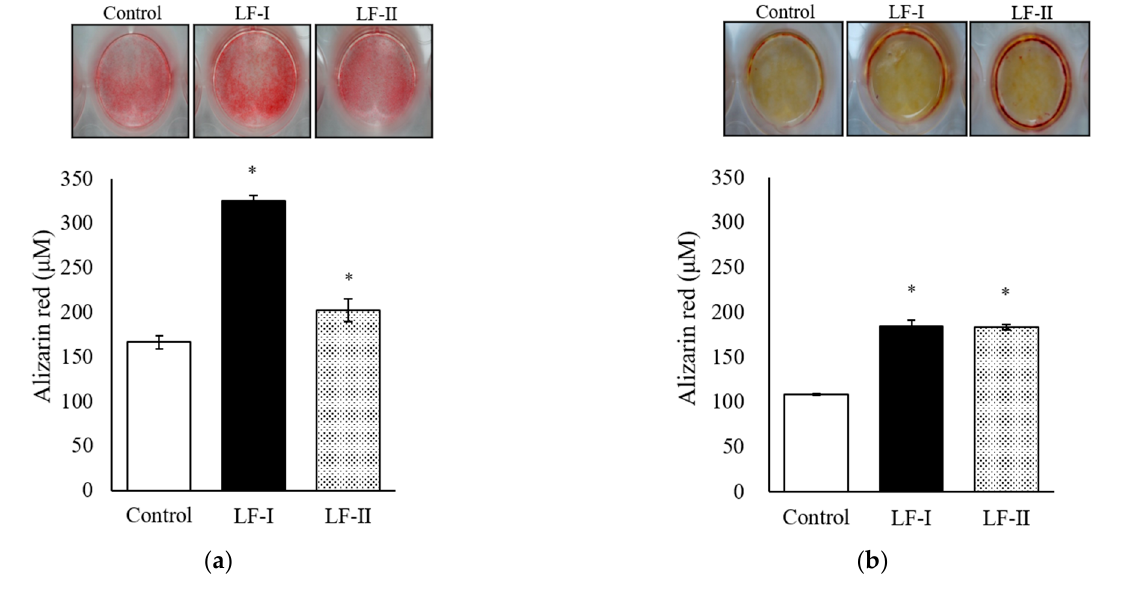
Figure 3. Result of alizarin red staining after 100 μ g/mL both LFs treatment with ascorbic acid (50 μ g/mL) and β -GP (10 mM) for ( a ) 1 week or ( b ) 4 weeks. ( a ) The 1-week experiment included HA (0.2 mM) for 2 days before alizarin red staining. ( b ) The 4-week experiment was performed without HA. Data are presented as means ± SD. * p < 0.05, compared with the control. LF, lactoferrin.